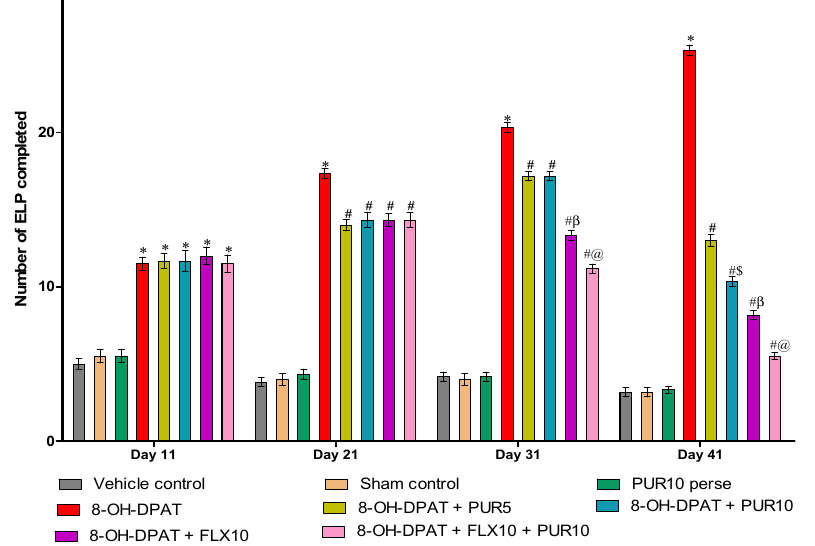
Figure 7. Effect of purmorphamine on excessive-lever-pressing behavior in 8-OH OCD. Statistical analysis followed by two-way ANOVA (post-hoc Bonferroni’s test). Values expressed as mean ± SEM ( n = 6 rats per group). * p < 0.01 v/s vehicle control, sham control and PUR10 per se; # p < 0.01